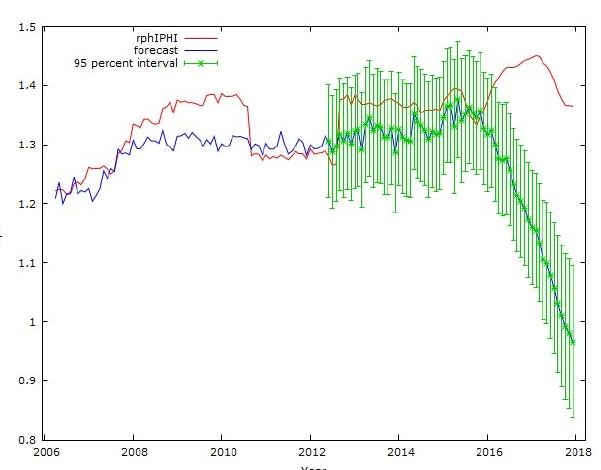
Figure A11. Time series forecasting in OLS for all variables, rph is a dependent variable, the in- sample January 2000–May 2012, and the out-of-sample June 2012–December 2017, base month January 2000 = 100.